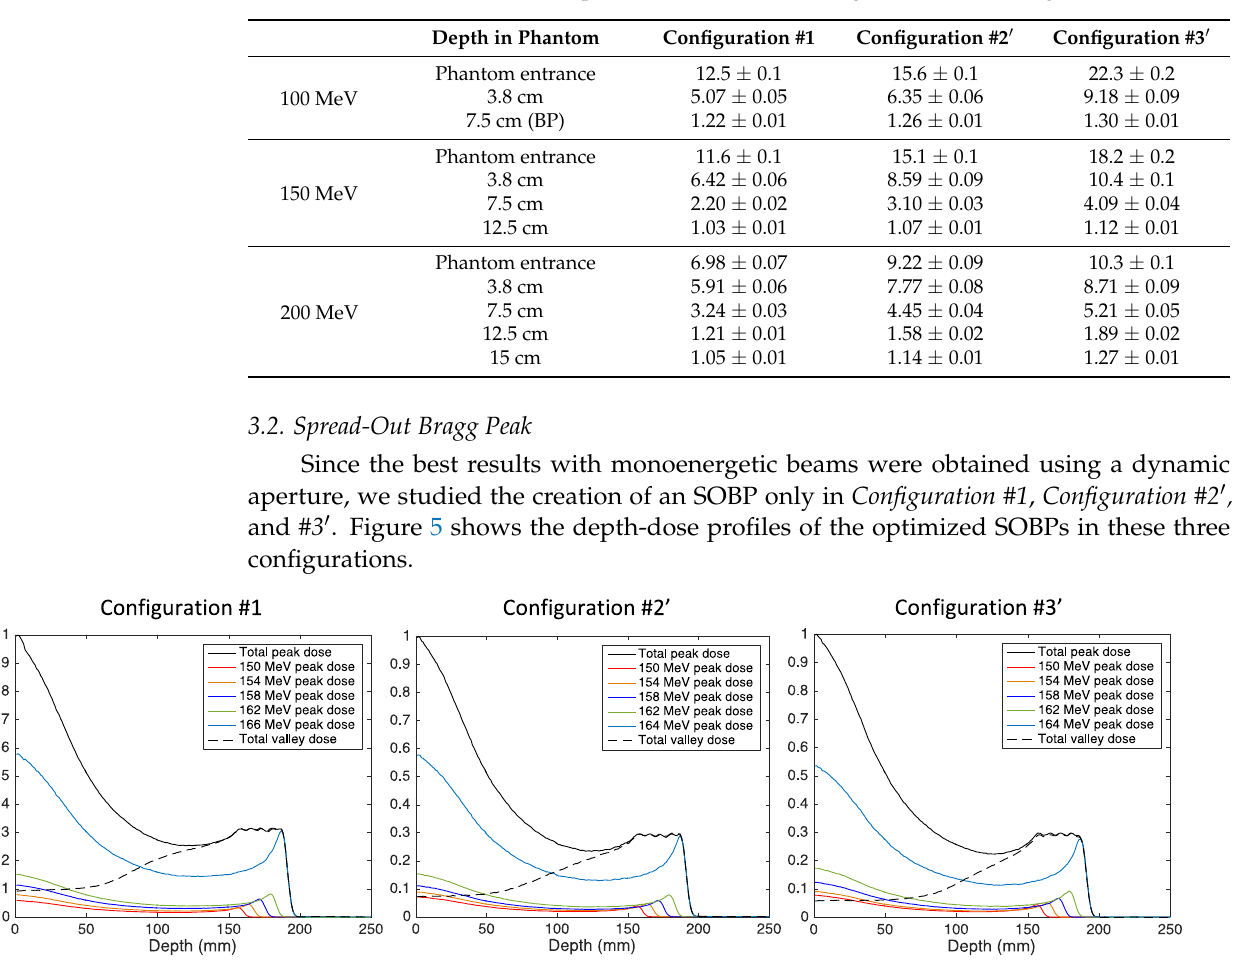
Table 2. PVDR as a function of depth for the three beam energies and three configurations.